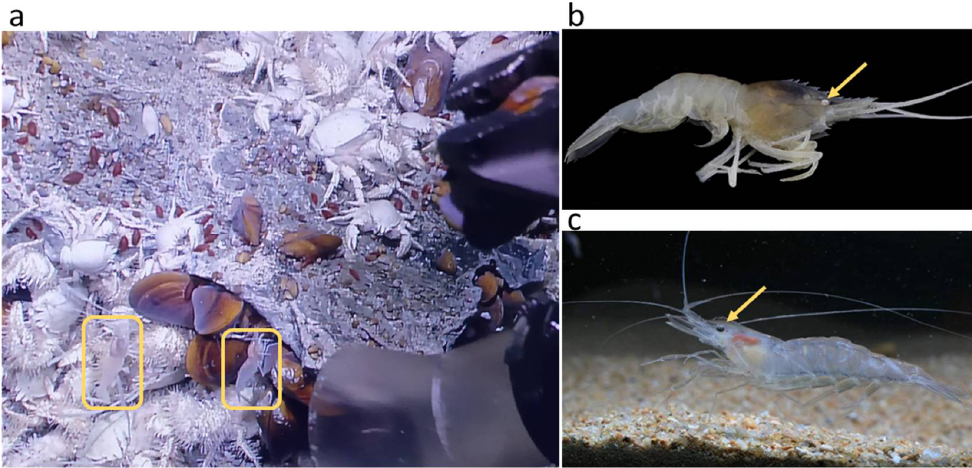
Figure 1. The living environment of deep-sea seep Alvinocaris longirostris ( a ), and photos of A. longirostris ( b ) and Palaemon carinicauda ( c ). The photos ( b , c ) are taken by Ziming Yuan and Chengzhang Liu, respectively. Shrimps A. longirostris are marked with yellow squares. The eyes of the two shrimp species are identified by the arrows.